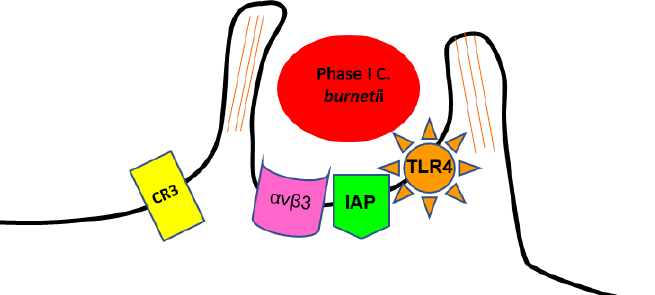
Figure 1. Scheme representing the internalization of phase I SCV of C. burnetii by monocyte-like